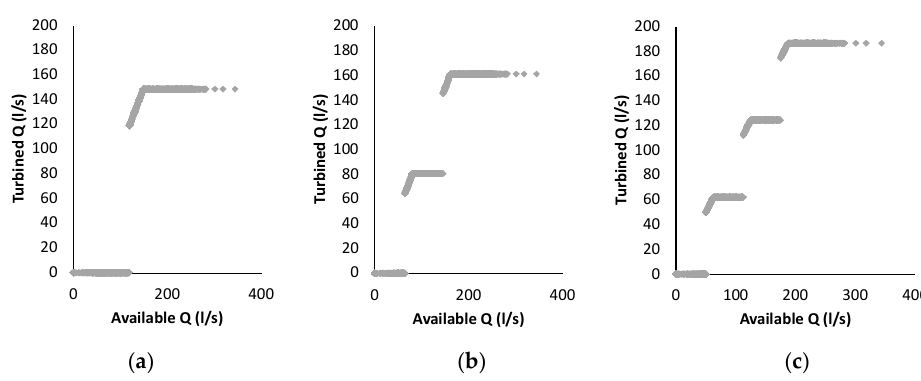
Figure 6. Turbined flow rate vs. the available flow rate at the site for ( a ) one PAT, ( b ) two PATs and ( c ) three PATs installed in parallel.